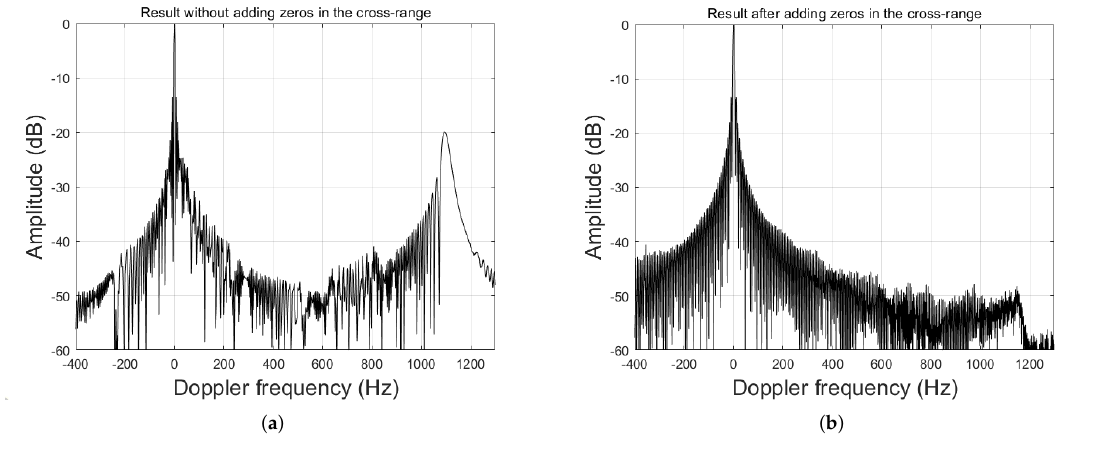
Figure 11. Diagram of the cross-range results. ( a ) The result without adding zeros in the cross-range. ( b ) The result after adding zeros in the cross-range. It is obvious that ( b ) performs better than ( a